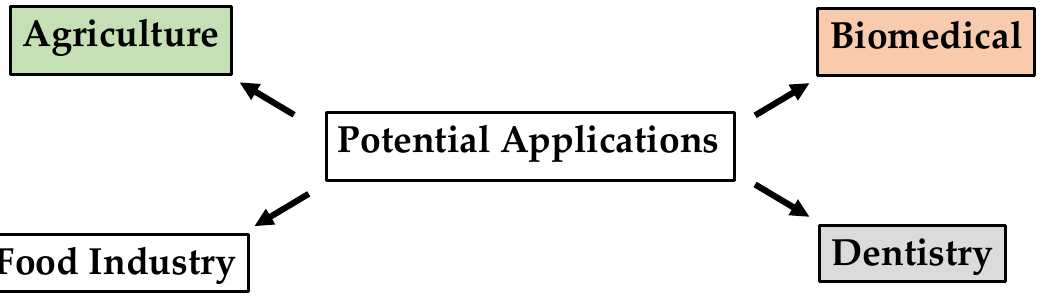
Figure 6. Potential application of NPs with antifungal activity to different industries.